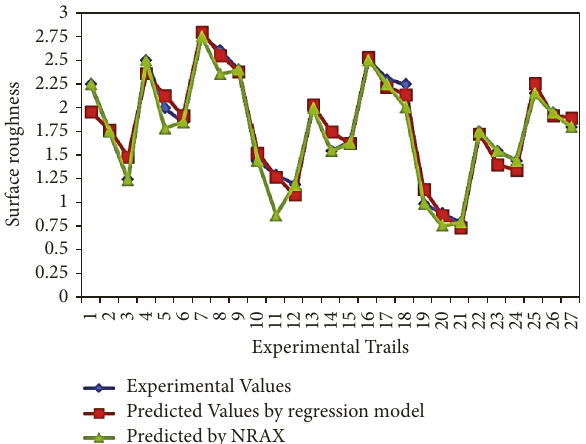
Figure 7: Surface values: experimental trails vs. regression model vs. NARX